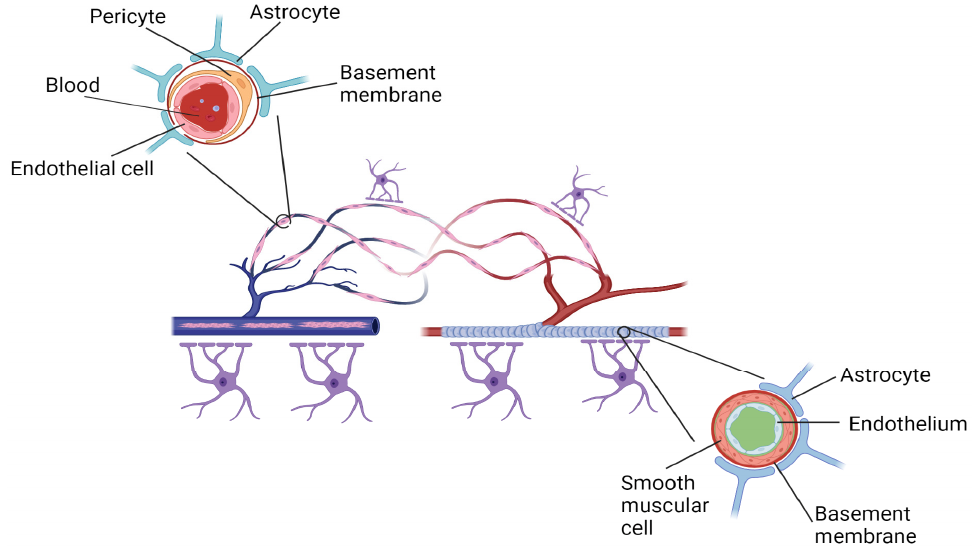
Figure 2. The neurovascular unit (upper part of the image) represents an interactive network of vascular cells (pericytes and endothelial cells), glia (astrocytes and microglia), and neurons. The blood-brain barrier is centrally positioned within the neurovascular unit and is formed by a monolayer of endothelial cells extending along the vascular tree. Created with BioRender.com, accessed on 28 November